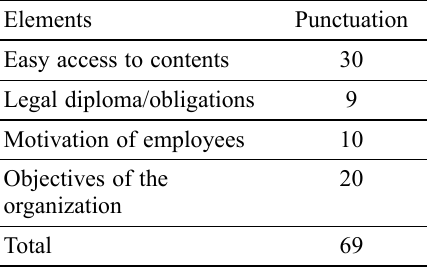
Table 14. Most important elements for